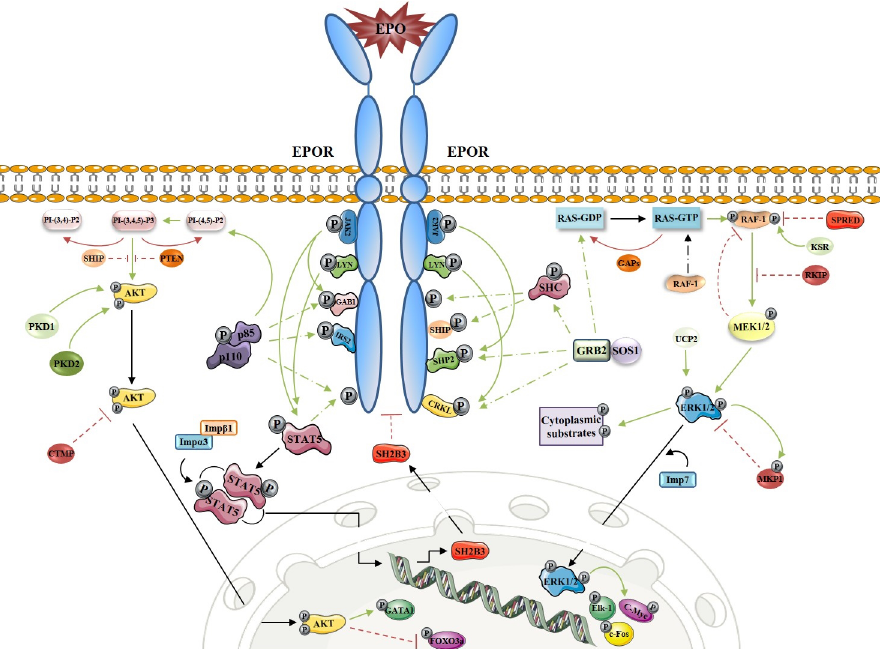
Figure 2. Molecular mechanisms of EPO-EPOR signal transduction pathways: STAT5 pathway, PI3K pathway and MAPK pathway. Red line indicates an inhibitory effect. Green line indicates the activation effect. Black line indicates transition (Figure was created using SMART servier medical art [18]. Figure adapted from